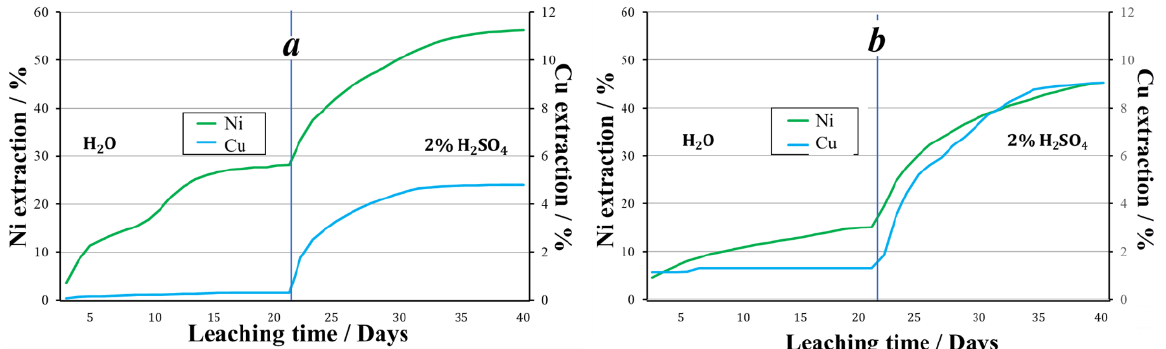
Figure 6. The extraction of metals during the leaching of granules treated with oxidizer: ( a ) — 2% H 2 SO 4 + Fe 3+ , ( b ) — 2% H 2 SO 4 + NO 2 − .